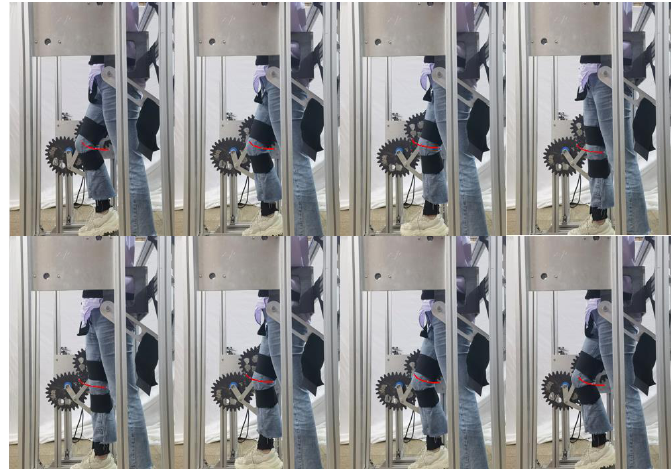
Figure 19. The movement state diagram of the lower limb when the knee joint passes through four task poses.